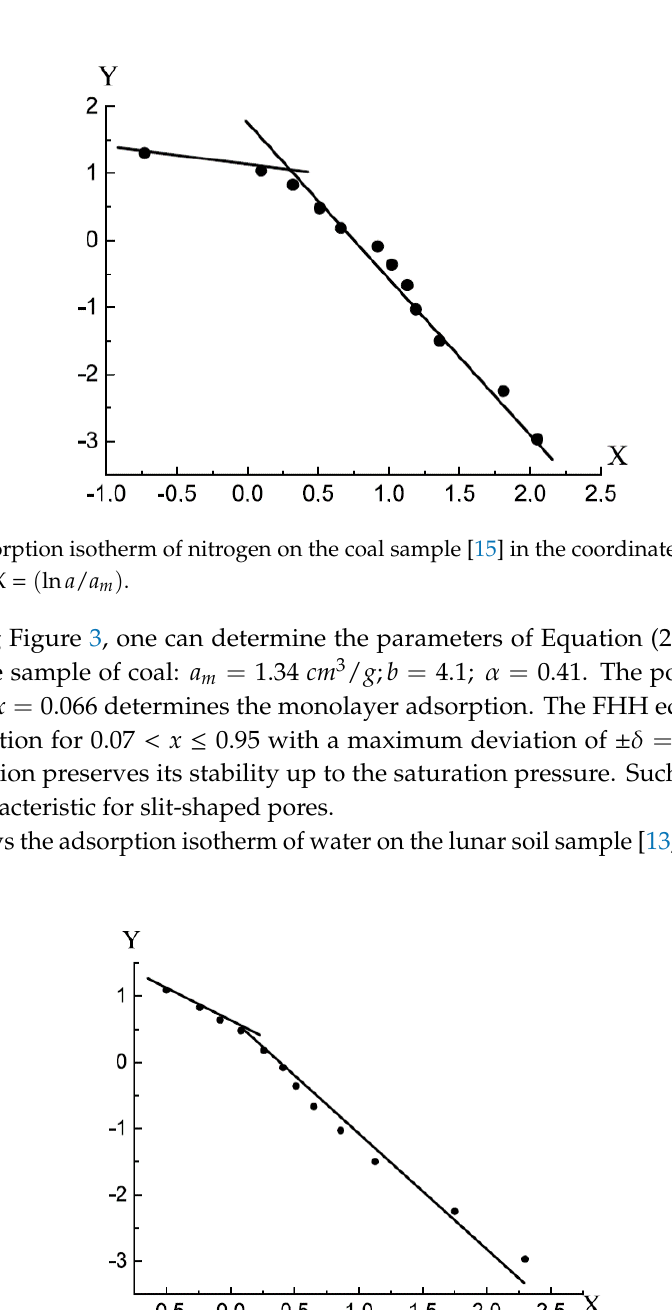
7 of 11 Figure 2. t-curve for N 2 gas adsorption isotherm of coal sample (BD3). On the other hand, to differentiate the regions of multilayer formation and capillary condensation in greater pores, we describe the isotherm by the equation considered by Frenkel– Halsey–Hill (FHH) [16]: 𝑎 = 𝑎 𝑚 ( 𝑏 −𝑙𝑛 𝑥) 𝛼 (27) In Equation (27), b and α are the parameters of the FHH theory. In the FHH theory, α has a value of 1/3 [17] for Euclidean surfaces. For a fractal surface, 𝛼 ≠ 1/3 [16].